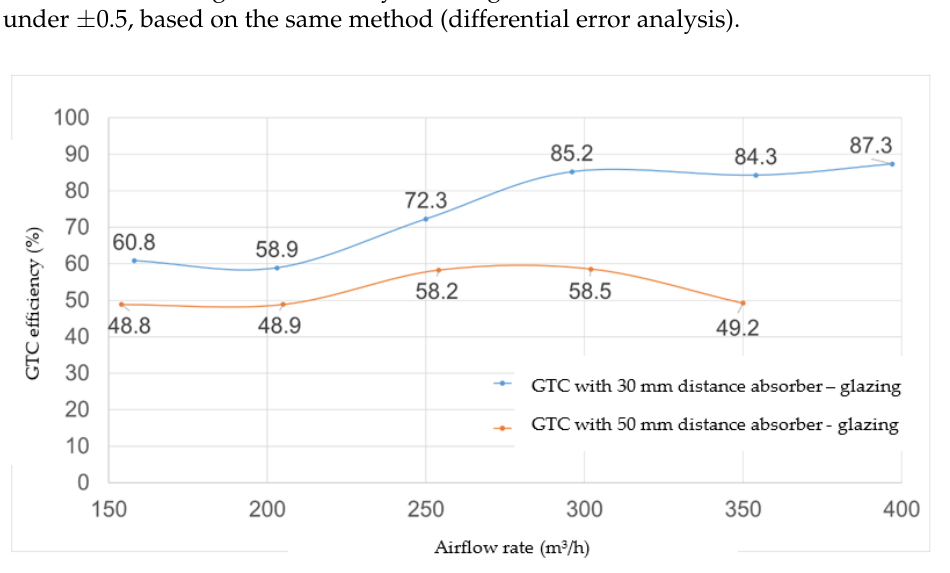
Figure 5. GTC global efficiency.